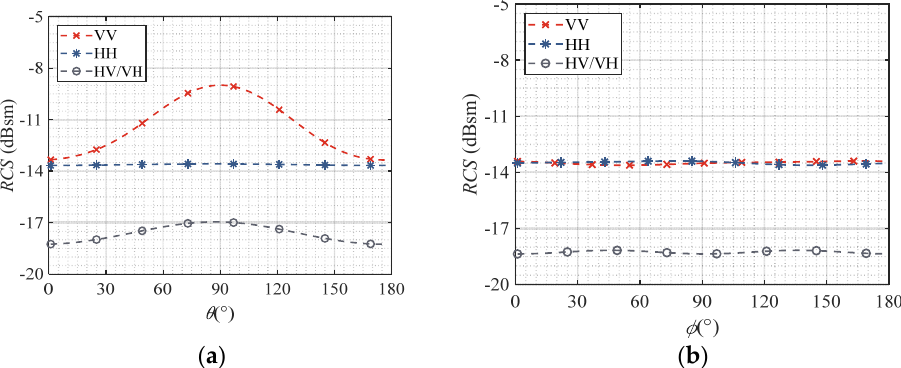
Figure 5. Angular distribution of the uniformly distributed chaff cloud RCS for different polariza ‐ tions. ( a ) Table 1. Comparison of computed RCS (dBsm) of a spherical chaff cloud.